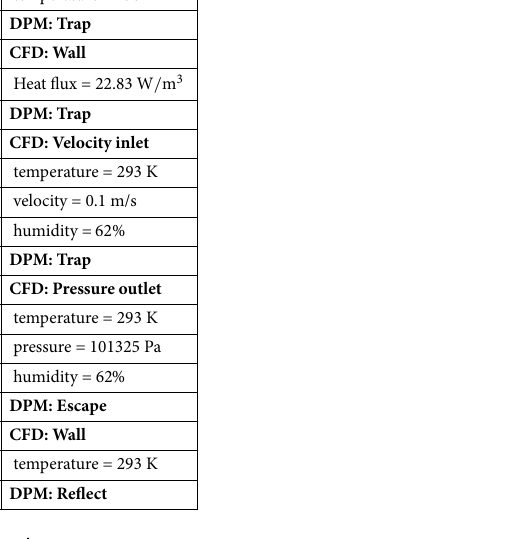
the injection, which is reliable 5 and is fitted by a Rosin–Rammler distribution in the range of 1–300 micrometer (Fig. 8). It was found that when the trajectory number was larger than 20,000, the predicted vapor concentration field was free from the number 49 . In order to investigate the scenario of wearing a face mask, a gauze filtering face-piece respirator is mimicked to be positioned above the mouth of the manikin in Case 2/5/7/8 by employ- ing the realistic filtration efficiency (as shown in Fig. 9 54 ). Therefore, the diameter distribution of droplets in a normal cough duration is reconstructed with values ranging from 1 to 40 µ m (Fig. 10). The time-dependent mass-flow rate of a cough behavior within a duration of 0.5 s (discrete by Yan et al. 48 , based on the experimentally measured data in 55 ) with Rosin–Rammler distribution is implanted by user-defined functions and is fitted as the red line in Fig. 11. In addition, the blue dashed line represents the face mask situation and is approximately 10% the value in the normal group. Physical models. Governing equations of continuous phase. For the CFD model 36 , multi-phase flow with gas and liquid is modelled by an Eulerian–Lagrangian frame. For simulating the humidity, the ambient air is an Eulerian n continuous gas phase and is selected as a multi-component of dry air and water vapor. As a homoge- neous mixture, the thermal dynamic properties φ mix ( C p , ρ , µ , (cid:31) , etc . ) of the gas phase are calculated by the mass fraction of the mixture species components 39 :